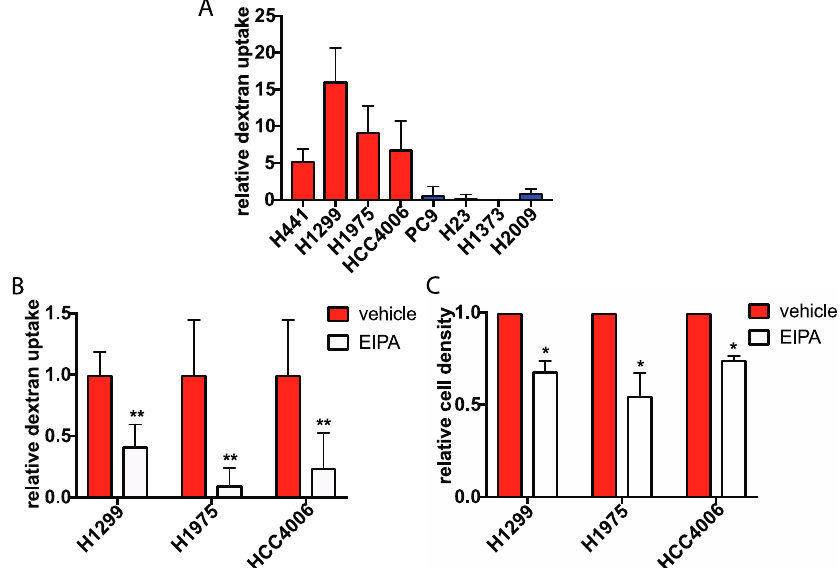
Figure 2. Macropinocytosis is increased in glucose independent cells and is required for growth in the absence of glucose. ( A ) Cells were cultured in GFM for 3 h prior to the addition of 1 mg/mL FITC-dextran for 1 h. Levels of FITC-dextran uptake in glucose independent (blue) and glucose addicted (red) cells was quantified and normalized to the cell line H2009. ( B ) Quantification of the levels of FITC-dextran uptake in glucose starved glucose independent cells treated with either vehicle or 10 µ m EIPA for 1 h prior to incubation with FITC-dextran. Data is normalized to vehicle treated cells. For ( A , B ), error bars indicate ± SD of 10 fields scored containing at least 10 cells. ( C ) Relative density of glucose starved cells treated with vehicle or 10 µ m EIPA for 48 h as determined by crystal violet staining. Data is normalized to density of vehicle treated cells at 48 h; error bars indicate ± SEM of three independent experiments. Significance was calculated using Student’s t -test, * p < 0.05, ** p < 0.005.